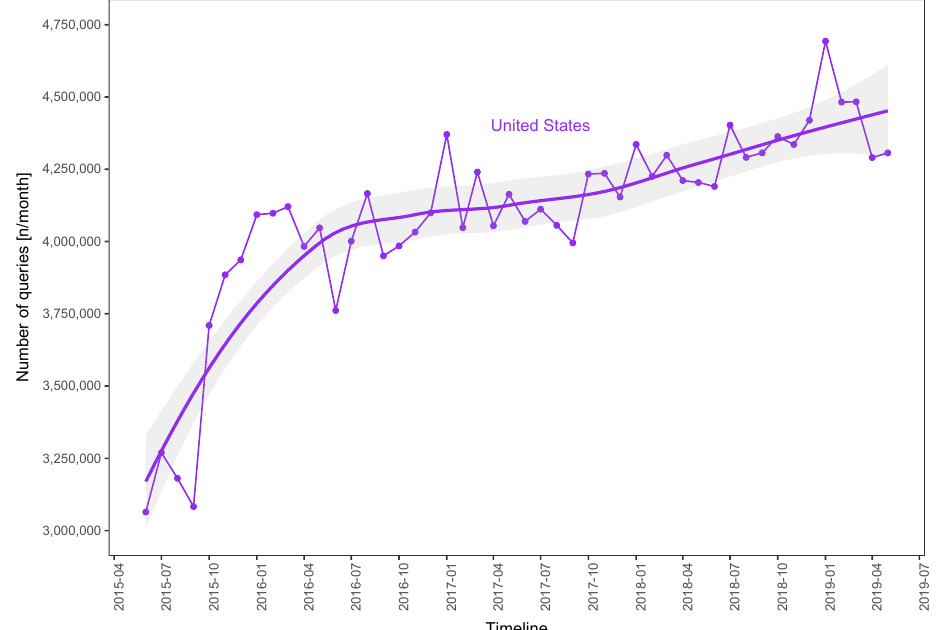
Figure 3. Number of heartburn-related Google queries from June 2015 to May 2019 in the United